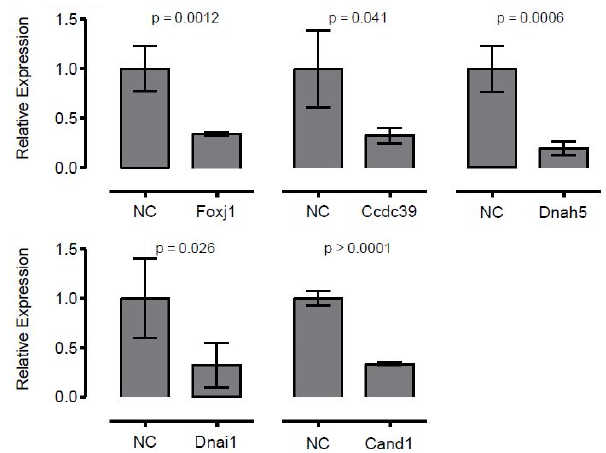
Figure 3. Knockdown of Foxj1 , Ccdc39 , Dnah5 , Dnai1 and Cand1 by siRNA shows significant reduction in expression of these genes as compared to negative control, scrambled siRNA (NC). This knockdown is apparent immediately (6 h) post-knockdown. All expression levels were normalized to actin. Error bars represent ± 1 SD.